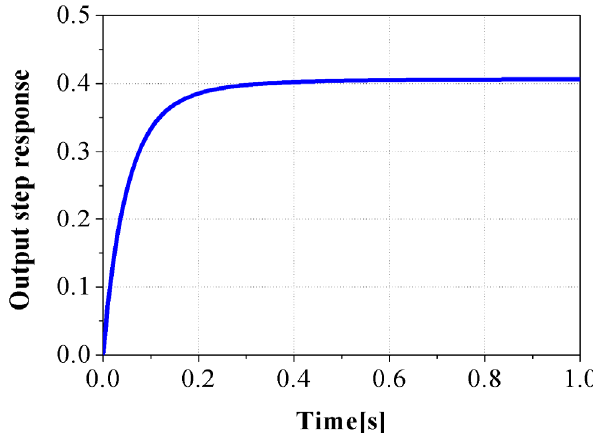
Figure 3. The step response of the system.